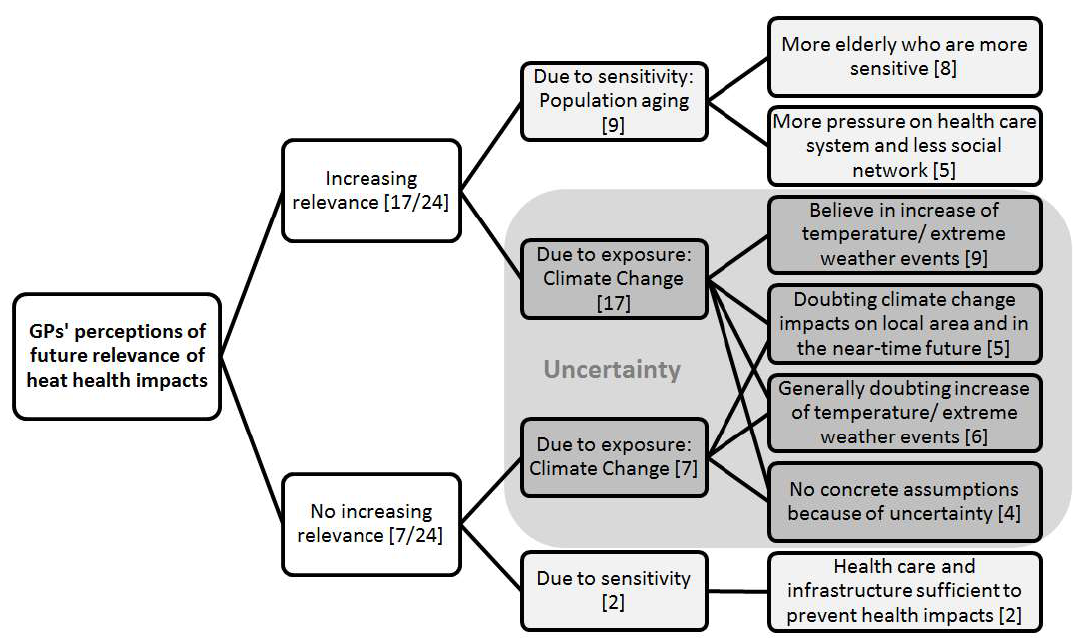
Figure 3. GPs’ perception of future relevance of heat health impacts on the elderly. Counts on the first level are exclusive [x/24], while counts on other levels [x] are not.